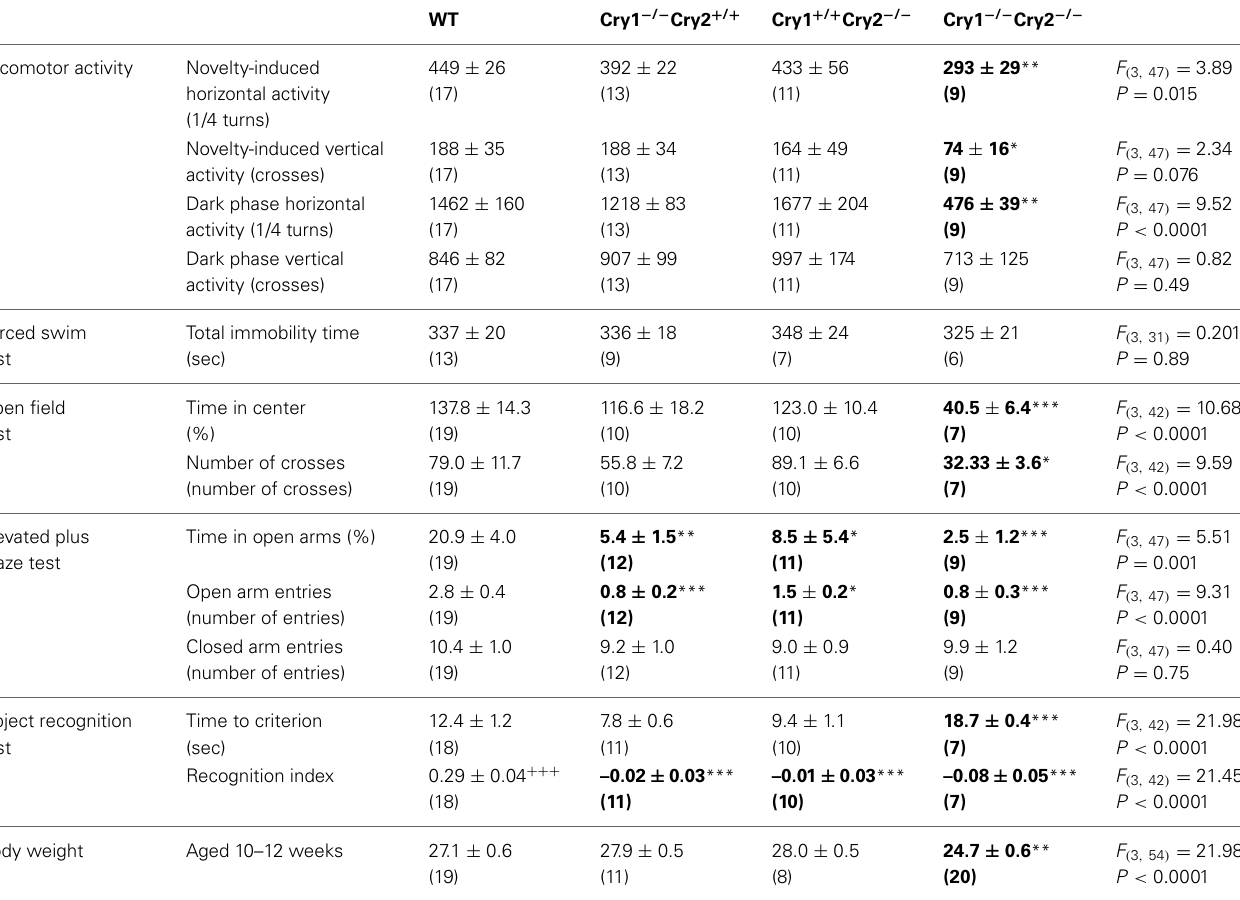
Table 1 | Behavioral profile of cryptochrome mutant